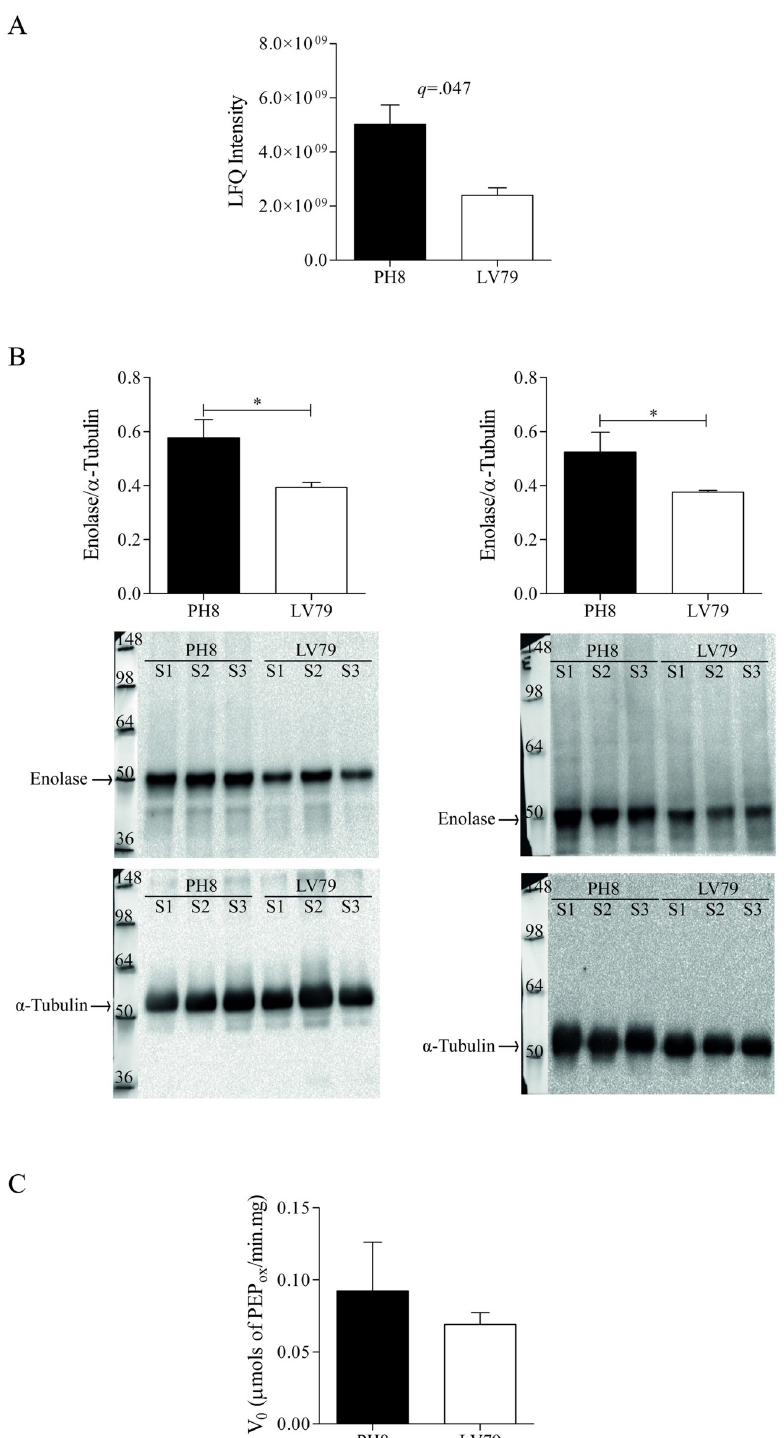
Fig 7. Enolase abundance and activity in L . amazonensis promastigotes of LV79 and PH8 strains. A. Enolase abundance (non-log transformed LFQ intensities) in proteomes of membrane-enriched fractions of LV79 and PH8. B. Enolase abundance in total extracts (left) and membrane-enriched fractions (right) (three biological samples (S1, S2 and S3) for each strain) of LV79 and PH8 by western blot. C. Enolase activity in total extracts was monitored by the PEP conversion to 2-PGA, which was measured spectrophotometrically at 240 nm. Data in A, B and C